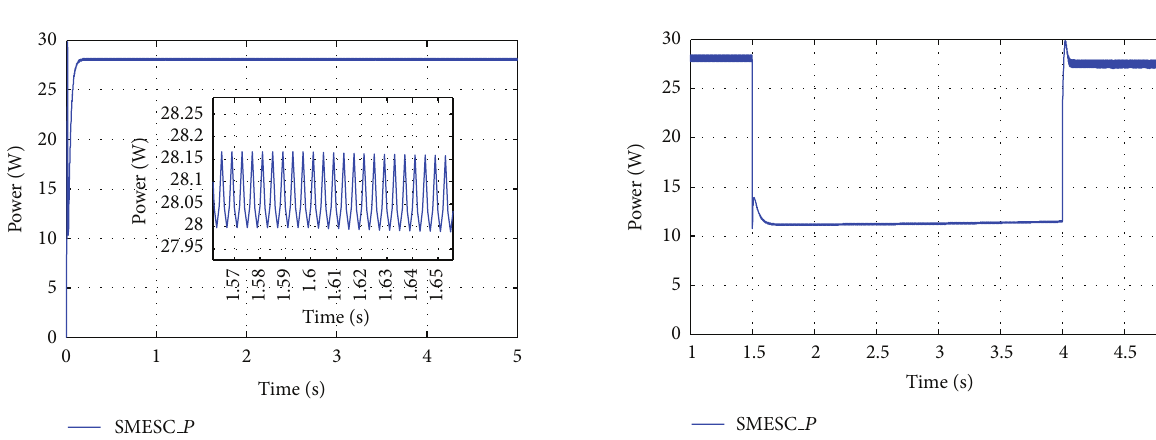
Figure 11: Simulation results for SMESC performance given step change in irradiance from 1000W/m 2 to 400W/m 2 followed by step change from 400W/m 2 to 1000 W/m 2